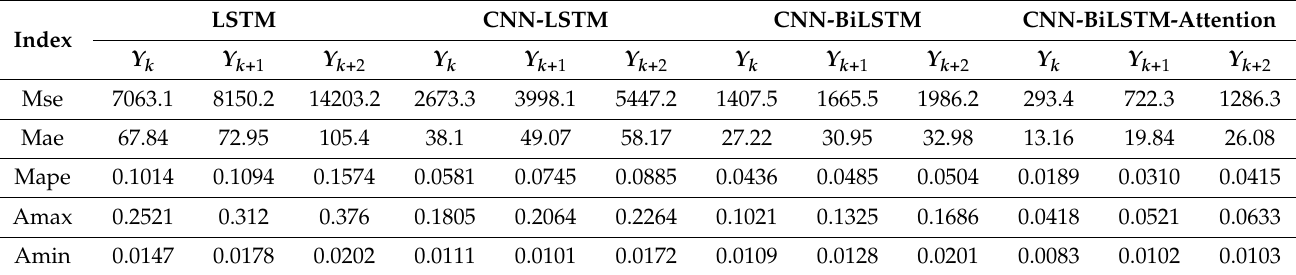
Table 2. Comparison of different models’ prediction